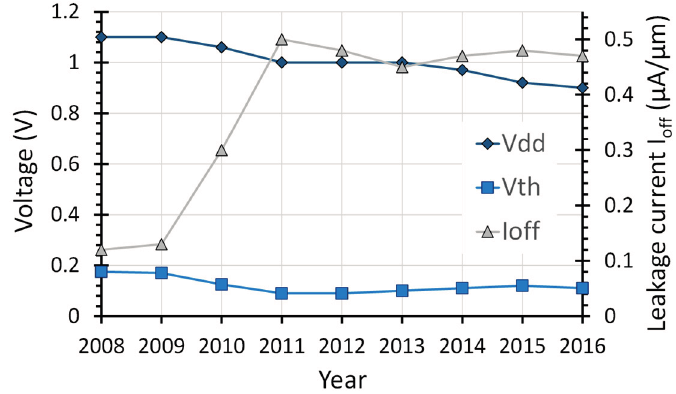
Figure 1. Trends for metal-oxide-semiconductor field-effect transistor (MOSFET) threshold voltage ( V TH ) and operating voltage ( V DD ), and corresponding transistor OFF-state leakage ( I OFF ), for high-performance digital logic [2].